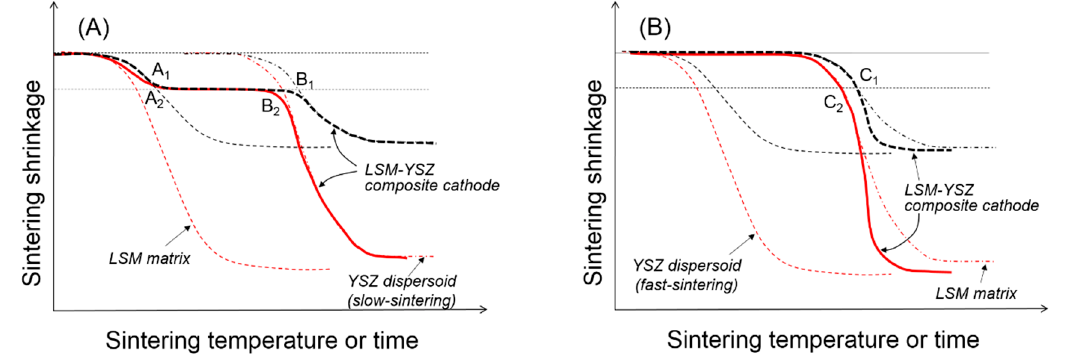
Figure 5. Sintering behavior of LSM-YSZ composite with ( A ) slow- and ( B ) fast-sintering YSZ particles dispersed in LSM matrix under constrained (red) and free (black) sintering conditions. dispersed in LSM matrix under constrained (red) and free (black) sintering